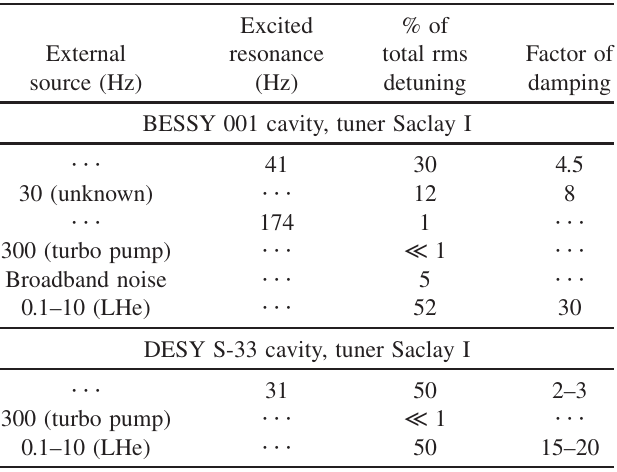
TABLE III. Overview of identified microphonics contributions (representative values), their fraction of the rms detuning level, and the typical reduction of this detuning source by the piezo control (at Q L (cid:2) 3 (cid:6) 10 7